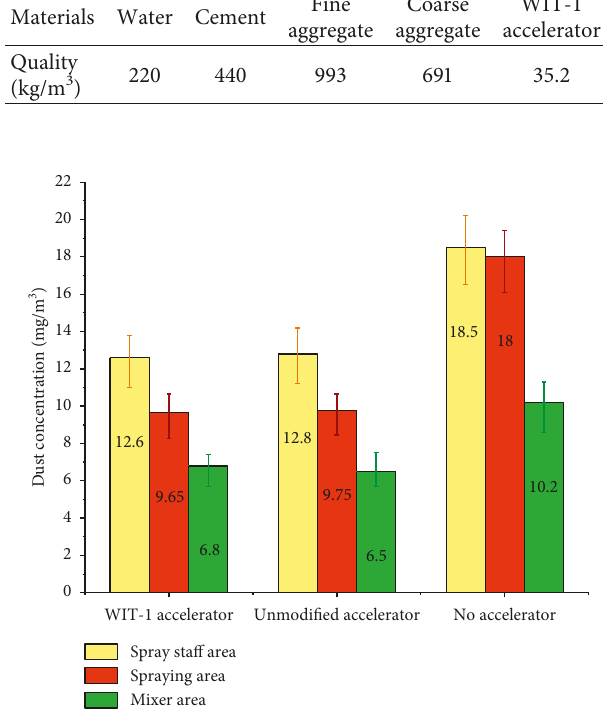
Figure 7: The comparison of three types of shotcrete dust